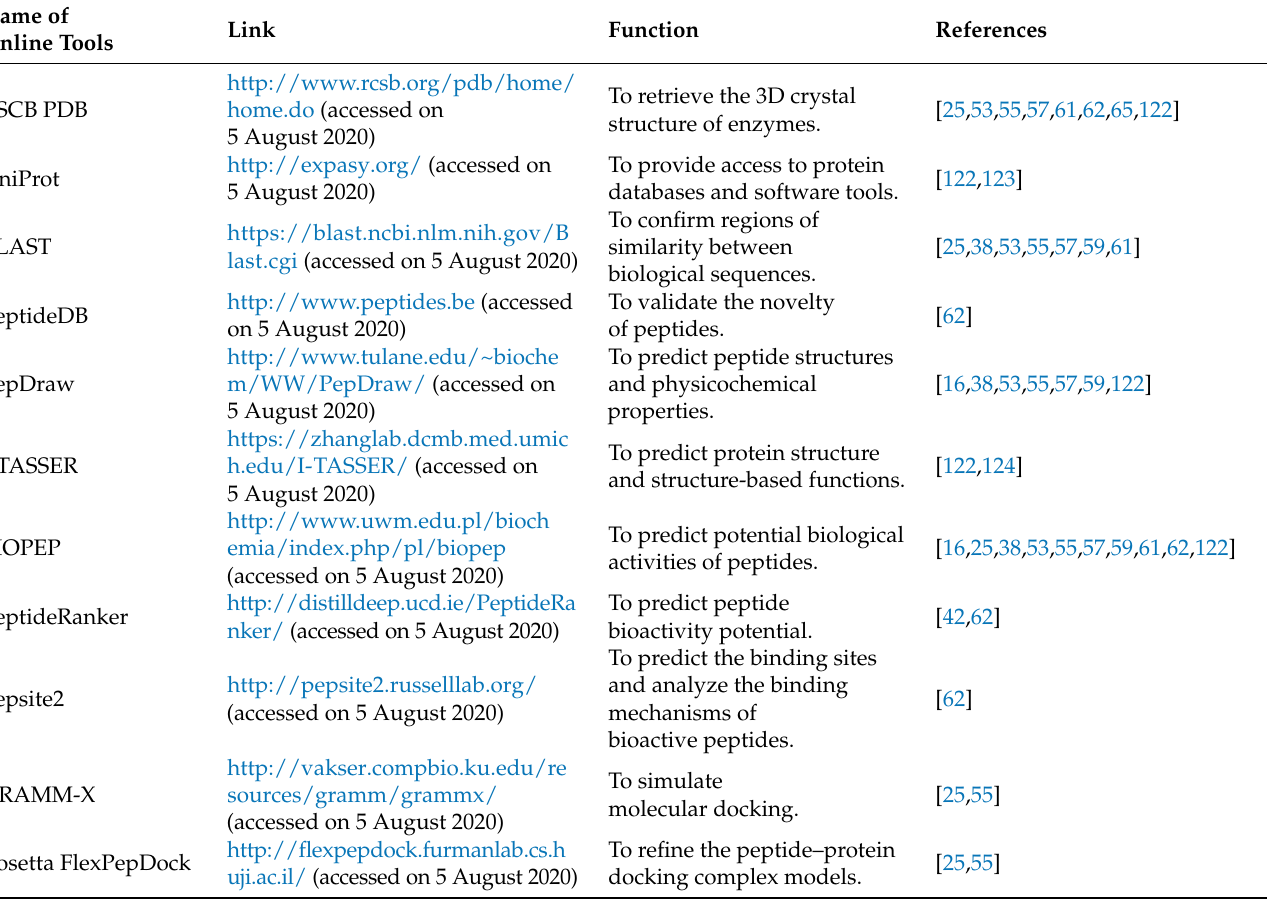
Table 7. Online tools used in leguminous antidiabetic peptides